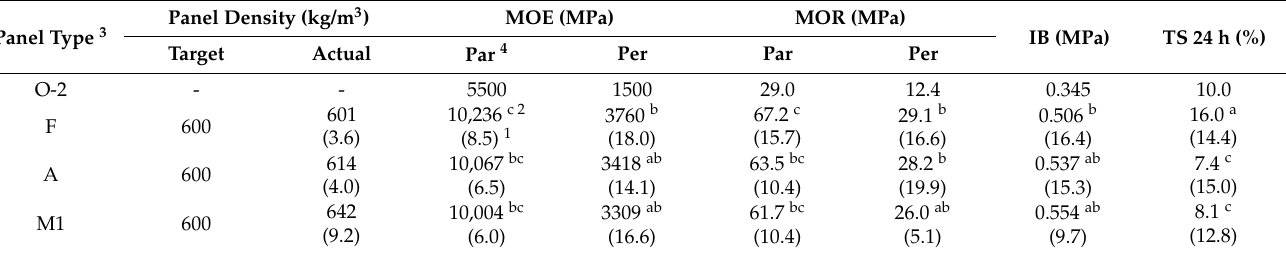
Table 3. Average property values for each species group.